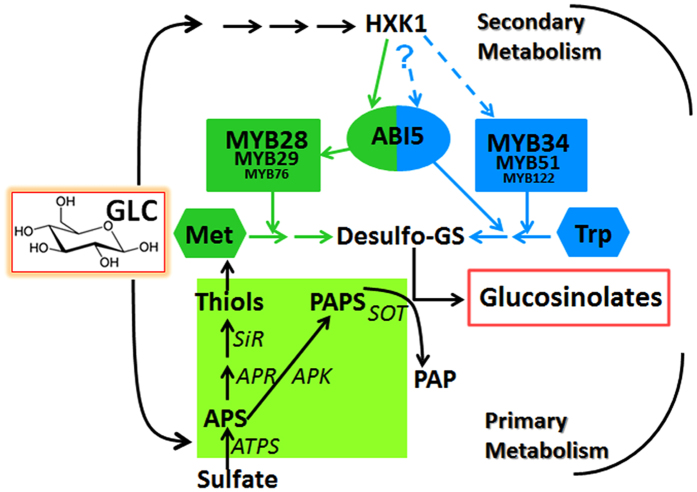
A model for glucose-regulated glucosinolate biosynthesis in Arabidopsis.Glucose plays a key and positive role in both primary and secondary metabolism. Symbols with light green color represent sulfate metabolism pathway. Symbols with dark green color represent aliphatic glucosinolate biosynthesis and regulation. Symbols with blue color represent indolic glucosinolate biosynthesis and regulation. Multiple enzymatic steps are indicated with interrupted arrows. GLC, glucose; Met, methionine; Trp, tryptophan; Desulfo-GS, Desulfo-glucosinolates; – – – –> possible activation.